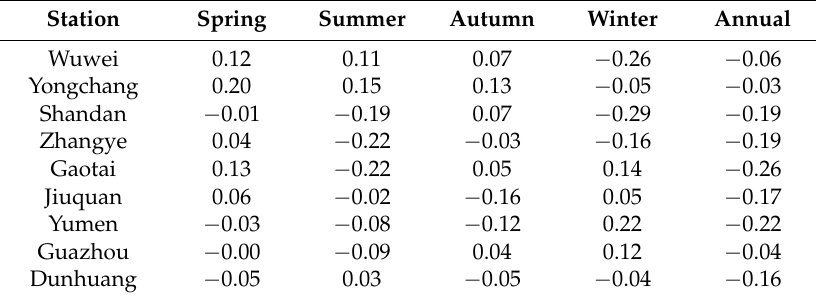
Table 6. Lag-1 serial correlation coefficients for seasonal and annual precipitation data.